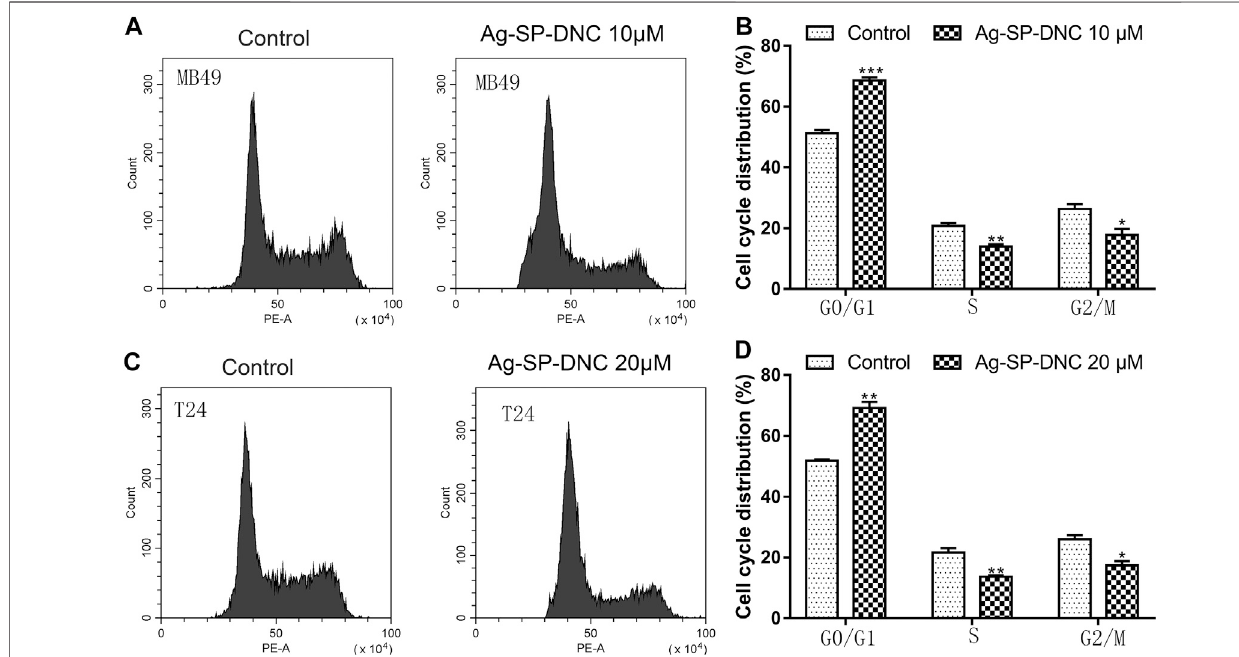
FIGURE3| Ag-SP-DNCinducescellcyclearrestatG0/G1stageinbladdercancercells.BladdercancercellsweretreatedwithAg-SP-DNCfor24 h,thenstained withPIandanalyzed using fl owcytometry. (A) A fl uorescencepatternofPIstainedMB49cellswithorwithoutAg-SP-DNC treatment. (B) Thestatisticaldataofcellcycle distribution.Dataaremean ± SEM;n (cid:1) 3.* p < 0.05,** p < 0.01,*** p < 0.001. (C) A fl uorescencepatternofPIstainedT24cellswithorwithoutAg-SP-DNCtreatment. (D) The statistical data of cell cycle distribution. Data are mean ± SEM; n (cid:1) 3. * p < 0.05, ** p < 0.01.